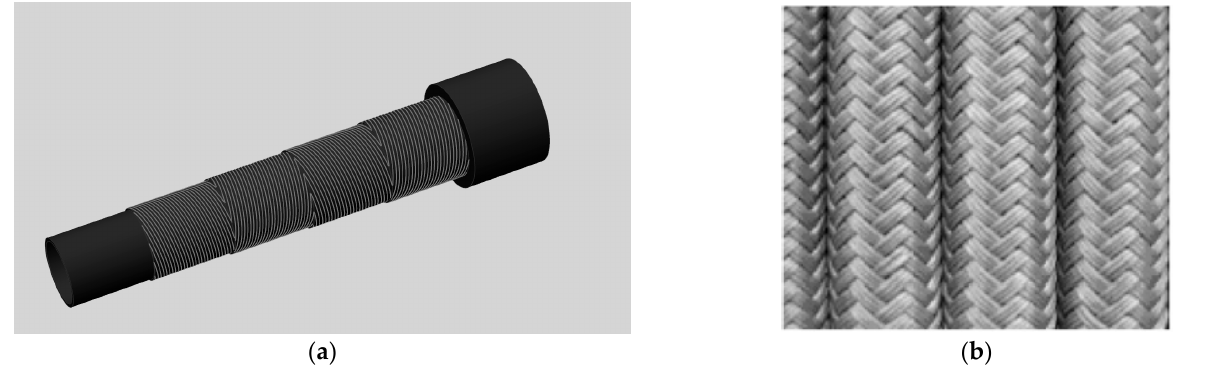
Figure 1. The operational principal of a typical industrial hose pump.